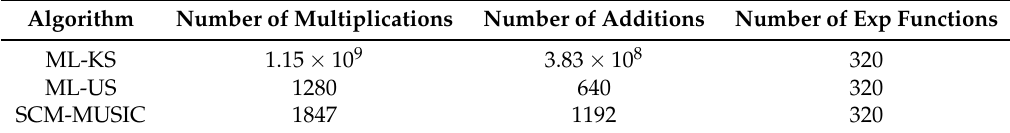
Table 1. An example of the numerical complexity of the proposed